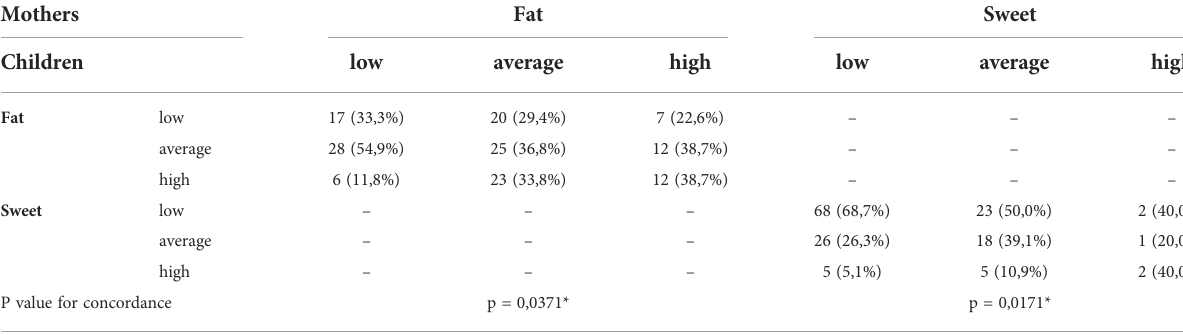
TABLE 2 Accuracy of recognizing the intensity of fat and sweet taste by mothers and children, and concordance between them.